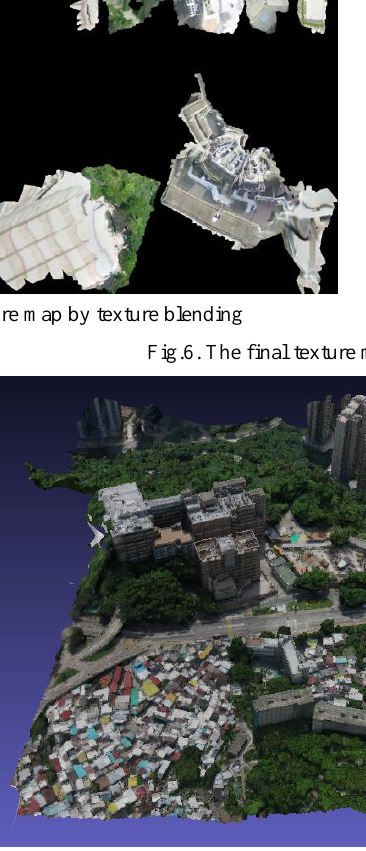
Fig.7. Photo-realistic visualization of a part of city